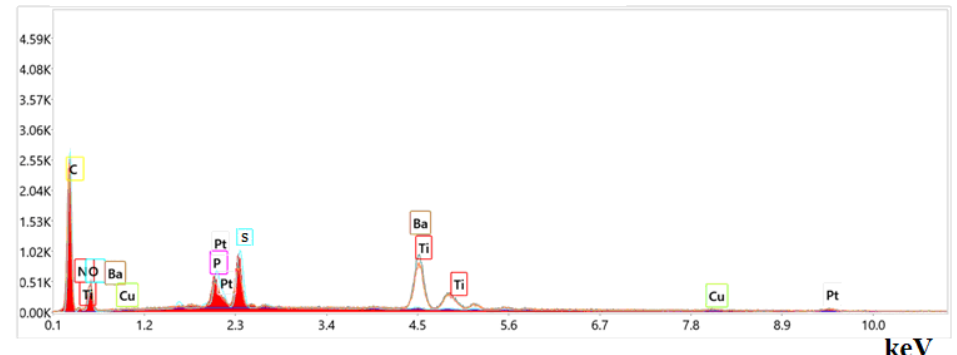
Figure 6. EDX of EP-4.